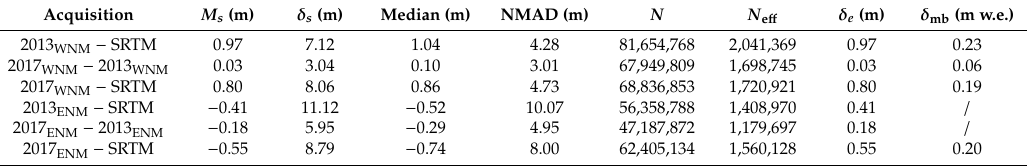
Table 5. Vertical errors in the elevation change represented by the statistics over the o ff -glacier region ( M s , δ s , Median and NMAD) and estimated uncertainties in glacier elevation change and mass balance. The final residuals between DEMs were set as systematic errors in the latter error assessment. Time of acquisition is expressed by the indicated year combined with a study area (ENM or WNM).